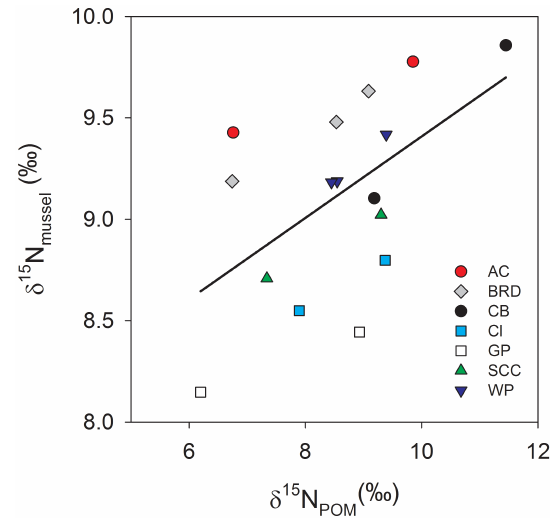
Figure 4. Relationship between mean δ 15 N of POM and mussel (‰). Linear regression is calculated using all data points ( r 2 = 0 . 303, y = 0.20x + 7.40, F 1 , 14 = 6 . 08, P < 0.05).